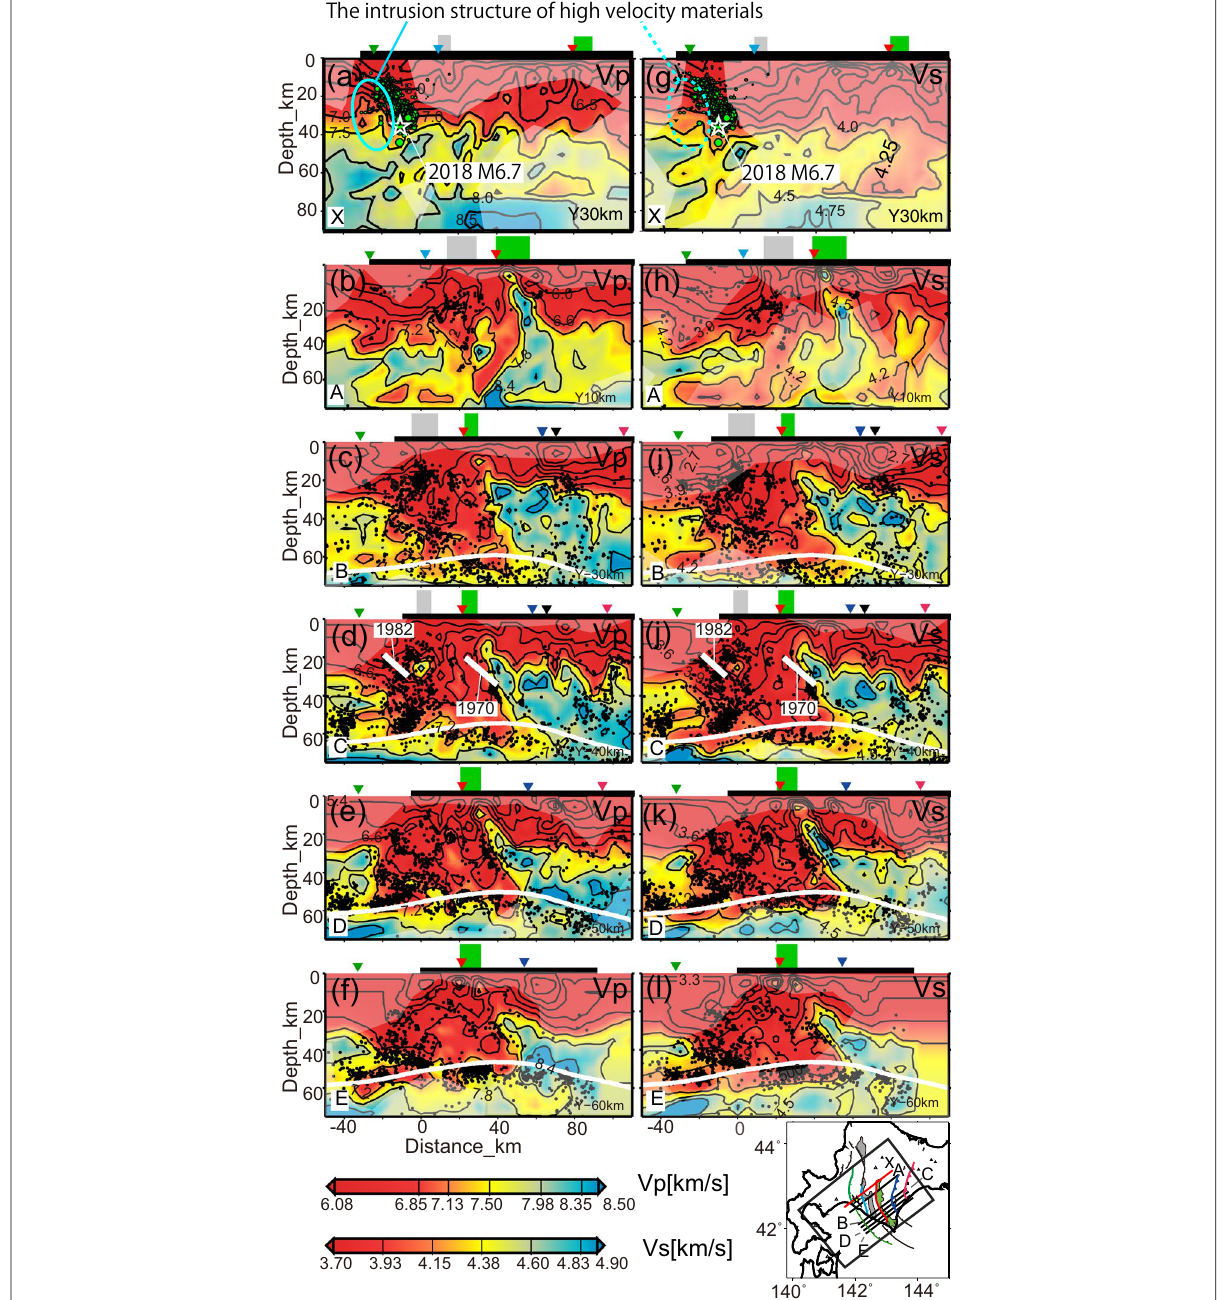
Fig. 4 Relocated hypocenters (green circles: aftershocks, white stars: mainshock) in the present study plotted on along-arc vertical cross-sections of the detailed seismic velocity structures estimated by Kita et al. (2012). Relocated hypocenters of aftershocks within 5 km from the vertical section were plotted. The locations of the sections are shown in the inset map. The thick white lines in d and j show the locations of the faults of the 1970 and 1982 events. (left) P and (right) S wave velocities are indicated by the color scale. Black dots indicate the hypocenters used in the tomographic inversions presented in Kita et al. (2012). Thick white lines delineate the upper surface of the subducting Pacific slab. Contours indicate P and S wave velocity values contoured at intervals of 0.6 and 0.3 km/s in b – f and h – l , respectively (and 0.5 and 0.25 km/s, respectively, in a , g ). Green and green dashed ellipses in a and g indicate the locations of intrusion of the high-velocity materials. The bold horizontal lines at the top of each plot represent the land area. Triangles at the top of the plots indicate the locations of thrust faults (green: thrust (extension of Ishikari-teichi-toen fault zone), aqua blue: Yubari-dake fault, red: Hidaka main thrust, dark blue: Tokachi Plain faults, pink: Urahoro fault). The green and gray rectangles and the gray area at the top of the plot indicate the locations of the Hidaka and Kamuikotan metamorphic belts, respectively. White-shaded areas indicate portions of DWS <